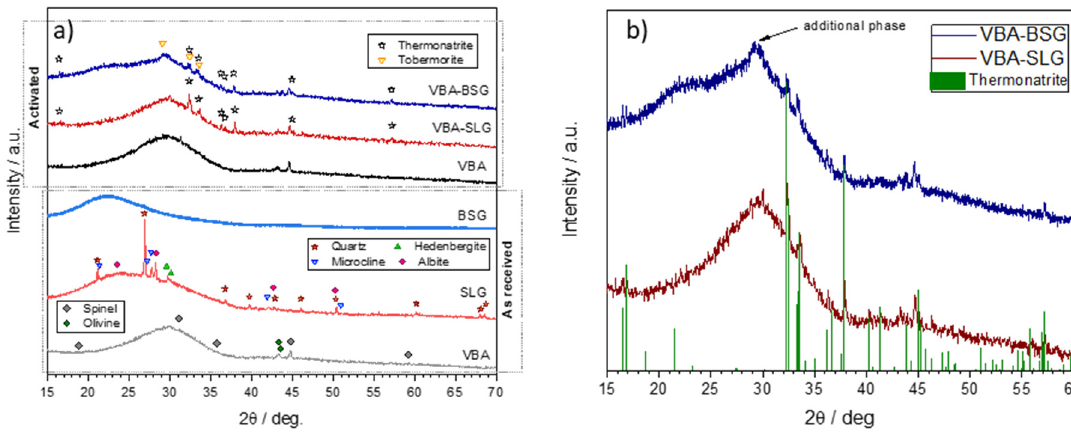
Figure 1. XRD analysis of starting materials and foams formed after alkali activation: ( a ) overall comparison; ( b ) detailed view of the patterns of the products of activation of VBA mixed with SLG and BSG glasses.